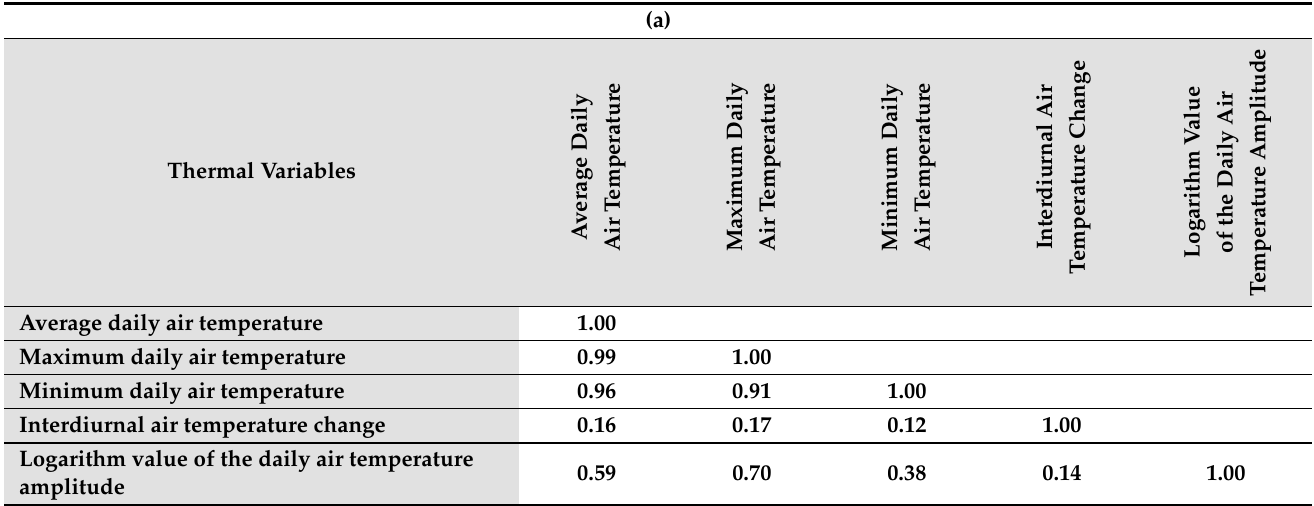
Table 4. Pearson’s linear correlation matrices for individual thermal and barometric variables. ( a ) Thermal variables. ( b ) Barometric